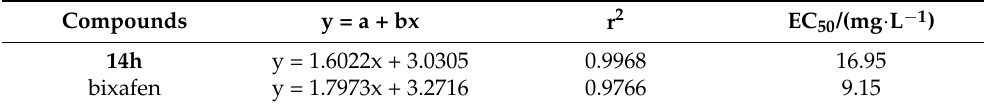
Table 3. EC 50 of compound 14h and bixafen to Pyricularia oryae ( PO